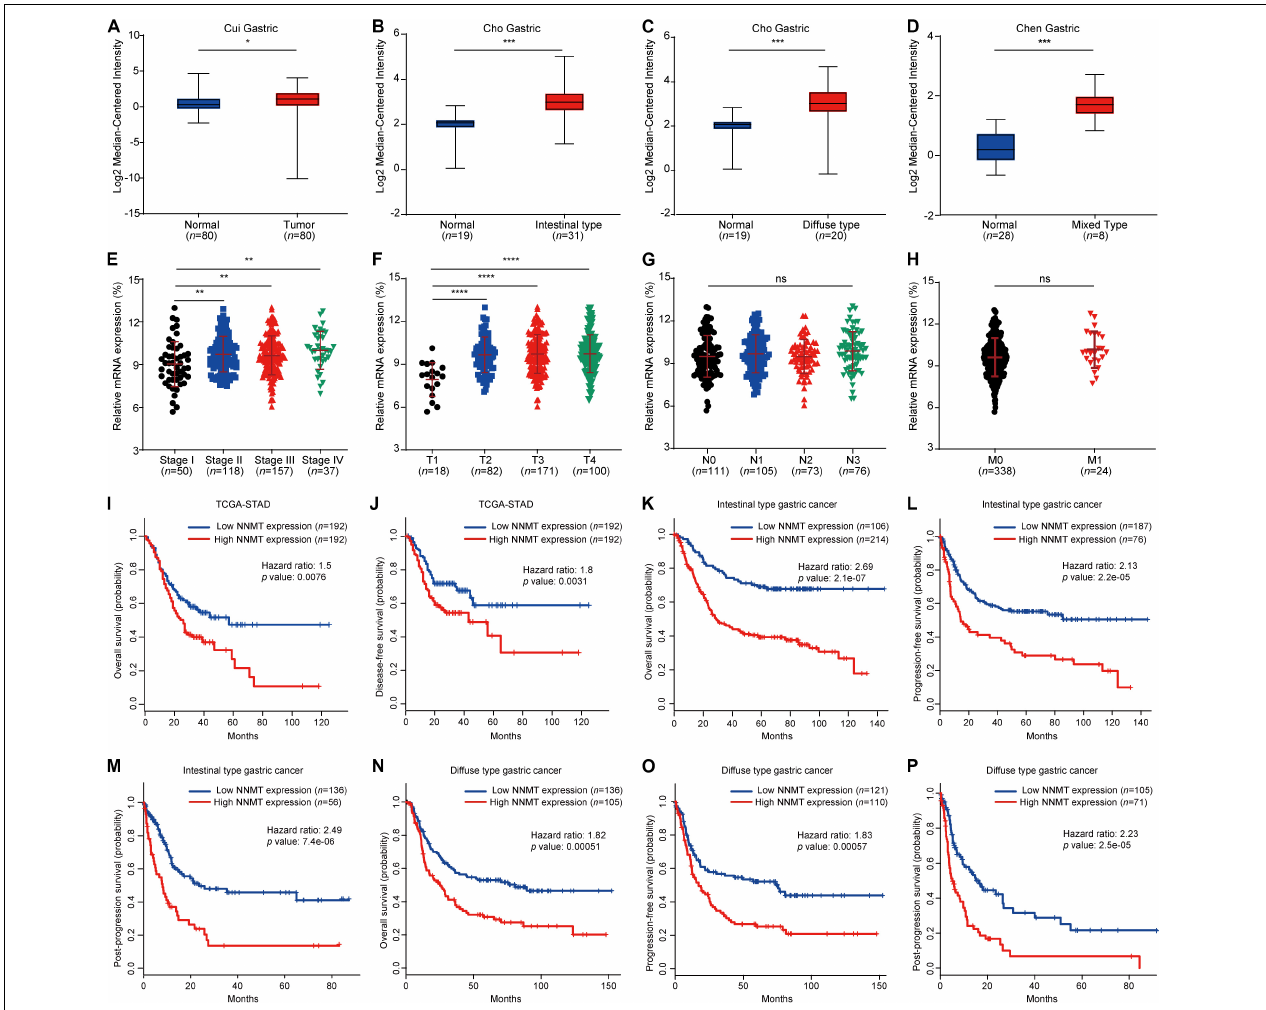
FIGURE 1 | Differential expression of NNMT in different disease state and survival curves of differential NNMT expression. (A–D) The relative mRNA expression of NNMT in three Oncomine datasets: Cui Gastric (A) , Cho Gastric (B,C) , and Chen Gastric (D) . (E–H) The relative mRNA expression of NNMT in patients with different stages of gastric cancer in the LinkedOmics database. ns, no significance, * p < 0.05, ** p < 0.01, *** p < 0.001, and **** p < 0.0001. (I–J) NNMT expression was associated with overall survival (OS) and disease-free survival (DFS) in STAD patients (GEPIA). (K–M) Kaplan-Meier curves of OS, FP, and PPS differences